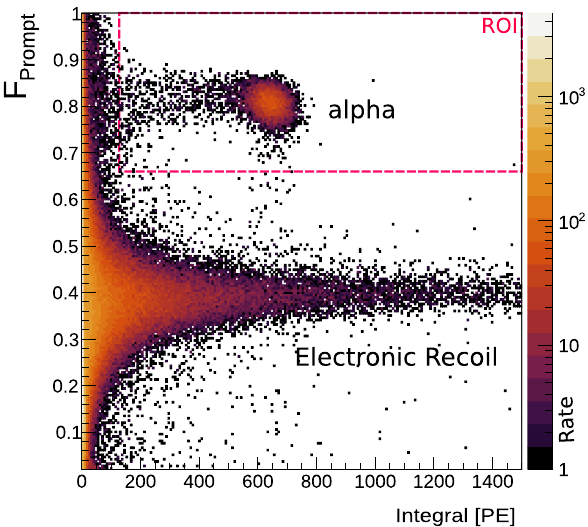
Fig. 11 Integral of the waveform versus the ratio F Prompt of the light integrated in the first 200 ns to that of the whole waveform, similarly to done in [41]. The alpha signal presents a higher ratio of prompt light, and can be discriminated from the background-induced ER band. The region of interest (ROI) is marked in red